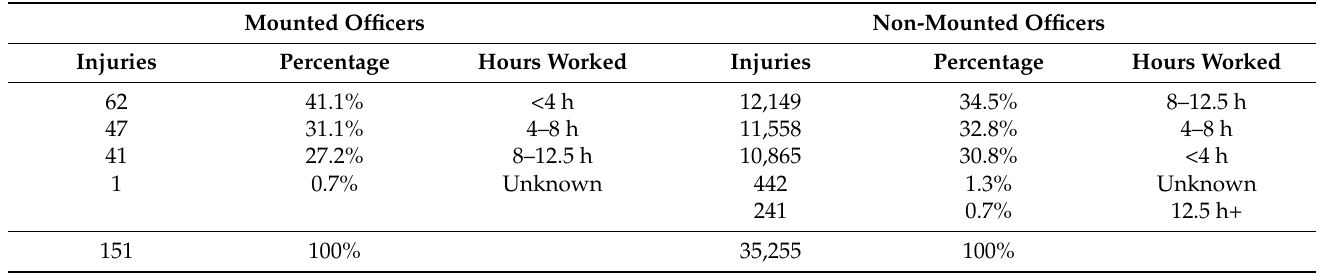
Table 7. Injury incident timepoint within a